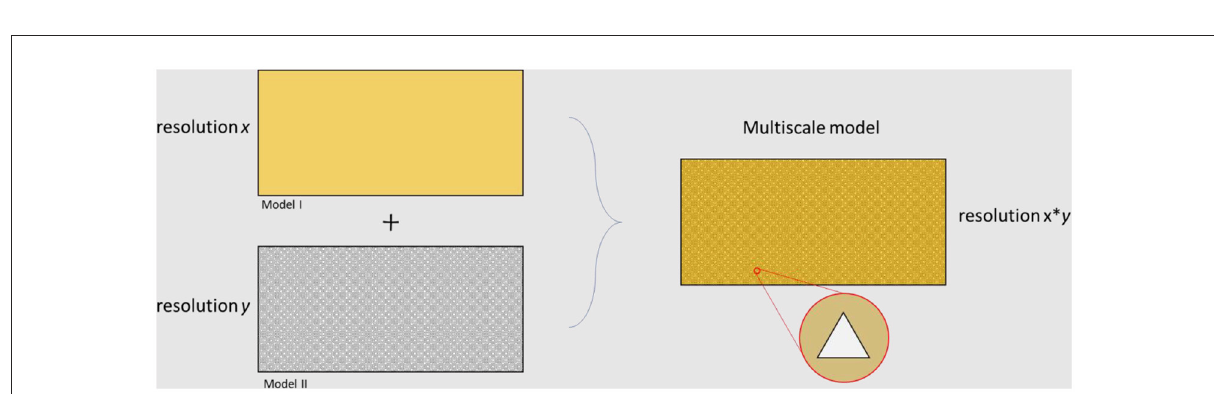
FIGURE5 Overview of different levels of resolution related to different modeling approaches. The final multiscale model is able to capture results at both resolution x and resolution y .